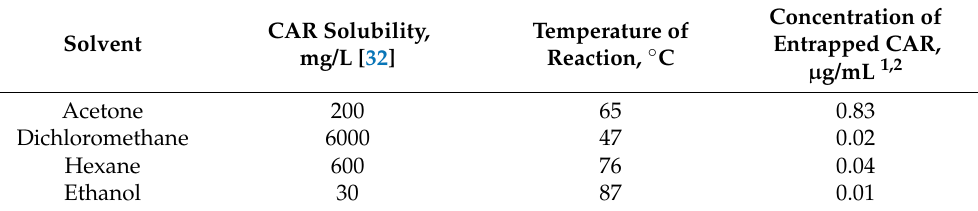
Table 2. The dependence of entrapped CAR content on CAR dissolution solvent.